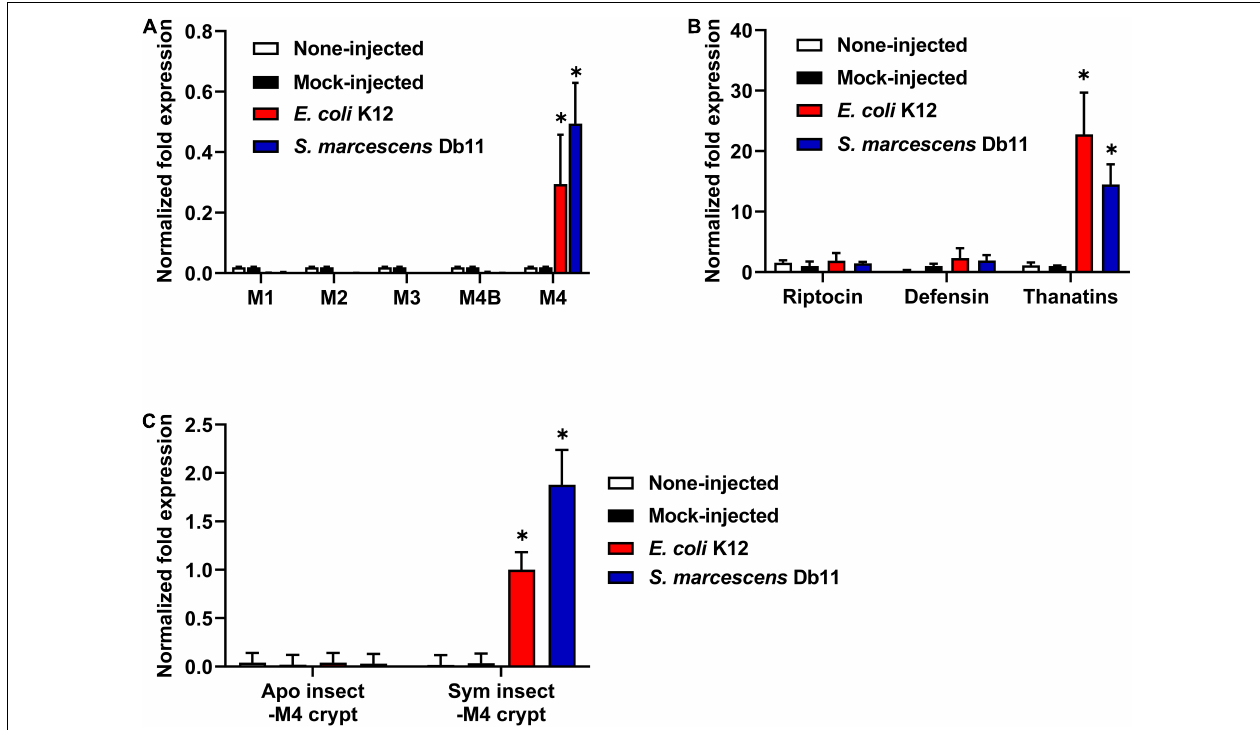
FIGURE 4 | The expression levels of thanatin genes in R. pedestris . (A) mRNA expression levels of thanatin genes in each midgut region (M1, M2, M3, M4B, and M4) of the Sym-male insect upon gram-negative E. coli K12 and S. marcescens Db11 injection. (B) mRNA expression levels of three AMP genes in the M4 crypt of the Sym-male insect upon gram-negative E. coli K12 and S. marcescens Db11 injection. (C) mRNA expression levels of thanatin genes in the M4 crypt of both the Apo-insect and Sym-male insect upon gram-negative E. coli K12 and S. marcescens Db11 injection. The ampicillin resistance gene ( amp ) was used as a mock-control in the RNA i experiment. The expression levels of the thanatin genes were normalized to the expression level of (A,C) E. coli K12-injected insect or (B) mock-control, which was set as 1. Error bars indicate the standard deviation of the mean ( n = 6). Asterisk indicates a significant difference between each group ( ∗ p < 0.01; unpaired t -test). ( A ; M1, M2, M3, and M4B vs. M4), ( B ; Riptocin or Defensin vs. Thanatins), and ( C ; Apo insect-M4 crypt vs. Sym insect-M4